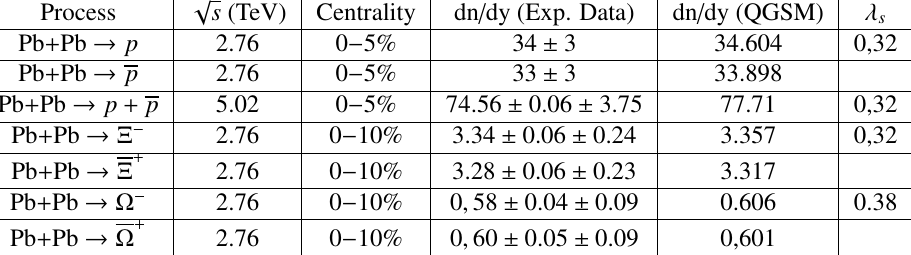
Table 1. Experimental data on dn / dy by the ALICE Collaboration of p , ¯ p central production at √ s = 2 . 76 TeV [39], of p + ¯ p central production at √ s = 5 . 02 TeV [41], Ξ − , and of Ξ − , Ξ production in central Pb + Pb collisions at √ s = 2 . 76 TeV per nucleon [40], and the comparison with the results of the corresponding QGSM